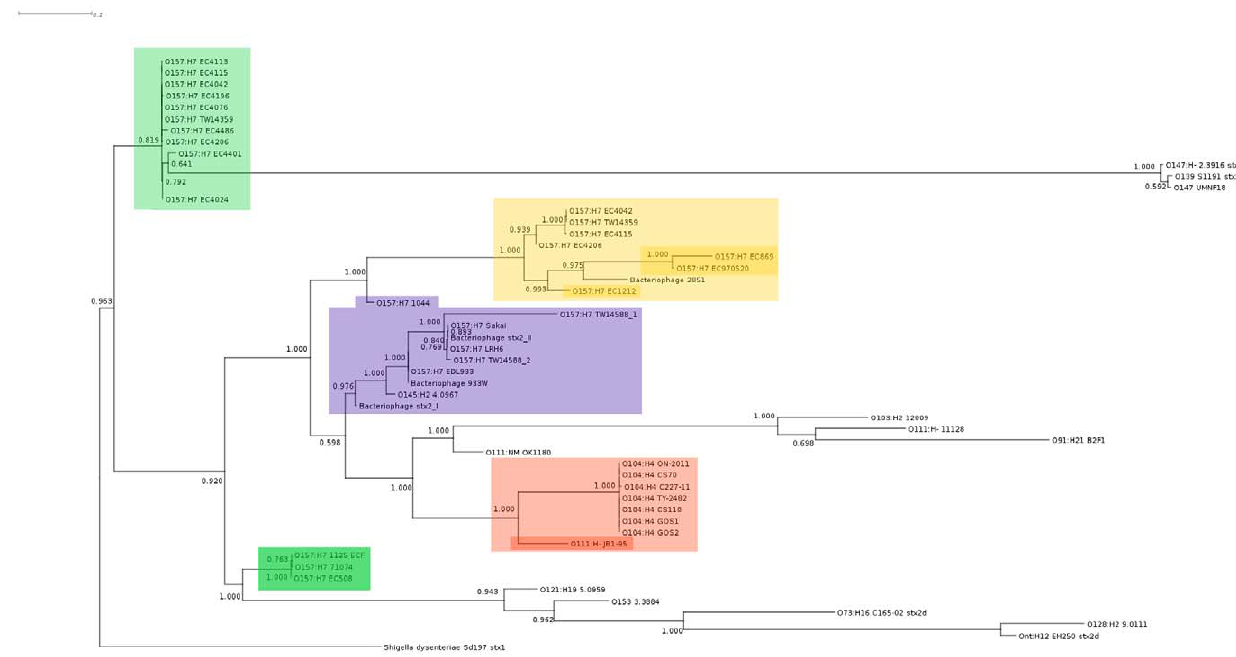
Figure 2. Maximum likelihood phylogram with aLRT branch-support values of the Stx2 ‘‘pan-genome’’ data among E.coli Stx2- bacteriophage and a bacteriophage from Shigelladysenteriae (Table 1). Labels represent the host-source of the bacteriophage as serotype followed by strain name. Red shading: Stx2-phage from O104:H4 outbreak isolates (light); O111:H- strain JB1-95 (dark). Purple shading: Stx2-phage from O157:H7 lineage I strains; related Stx2-bacteriophge; O145:H2 strain 4.0967. Green shading: Stx2-phage from O157:H7 lineage I/II strains; the sub-group of lineage I/II Stx2-phage most closely related to the O104:H4 isolate phage. Yellow shading: Stx2c-phage from O157:H7 lineage I/II strains and bacteriophage 2851 (light); O157:H7 lineage II strains (dark).